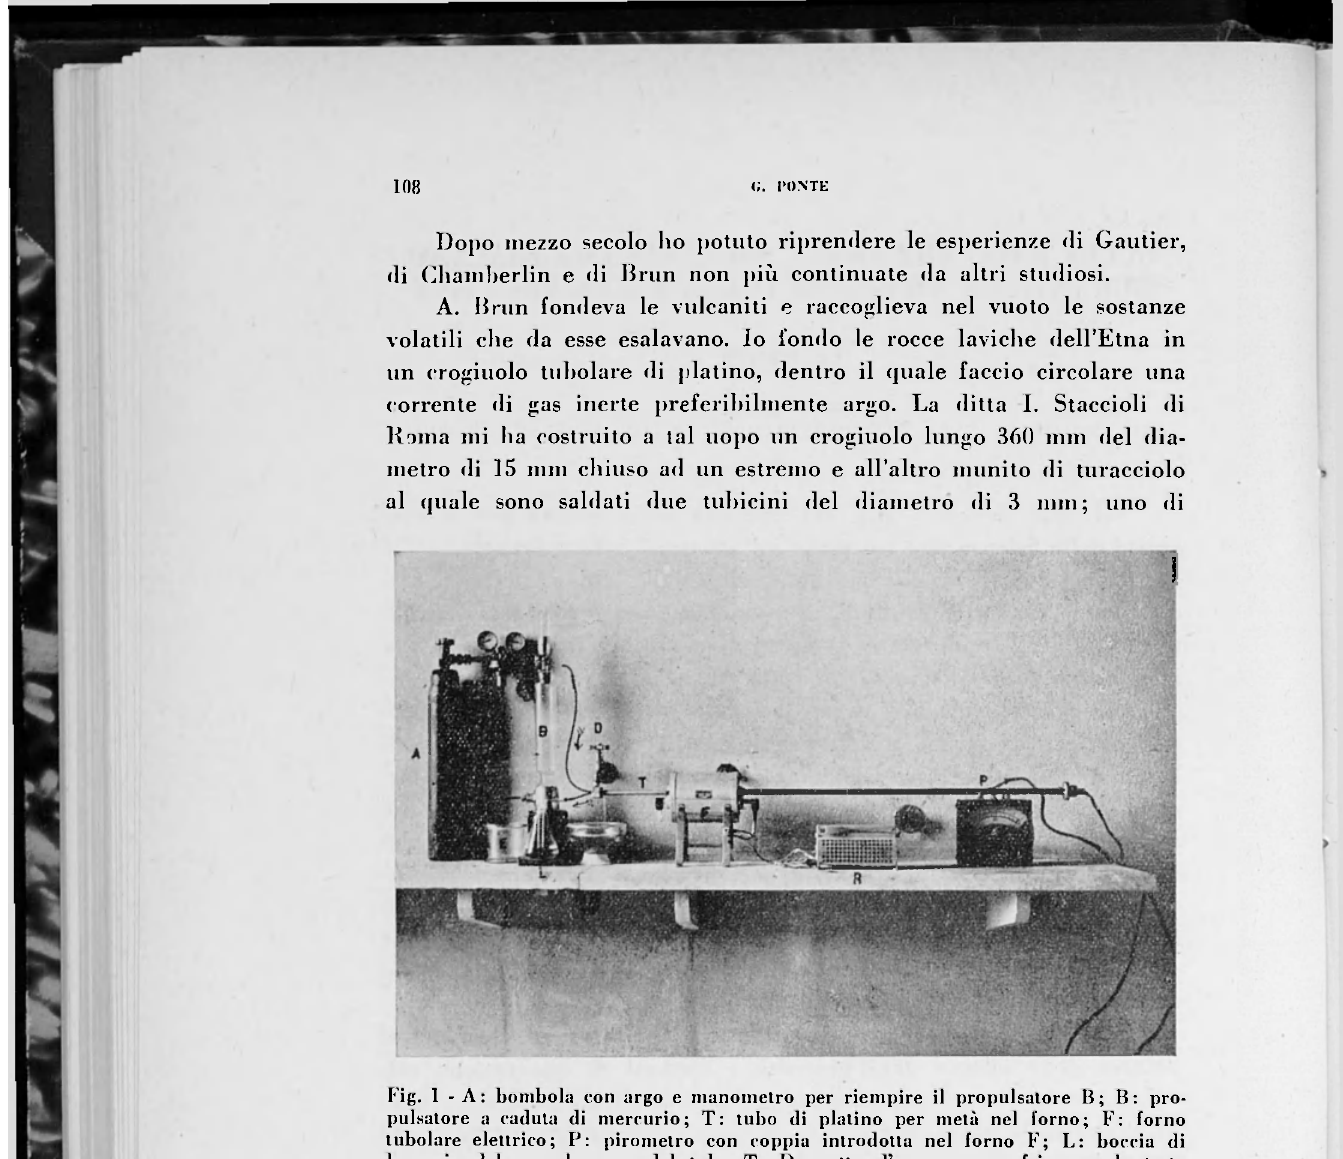
Fig. 1 - A: bombola con argo e manometro per riempire il propulsatore B; B: pro- pulsatore a caduta di mercurio; T: tubo di platino per metà nel forno; F: forno tubolare elettrico; P: pirometro con coppia introdotta nel forno F; L: boccia di lavaggio del gas elle esce dal tubo T; 1J : getto d'acqua per refrigerare la testa del tubo T; E: vaso per lo scarico del mercurio del propulsatole B essi è lungo quasi quanto il crogiuolo, l'altro sporge solo all'esterno e serve per l'uscita del gas inalalo nel crogiuolo attraverso il tubicino lungo durante la fusione della